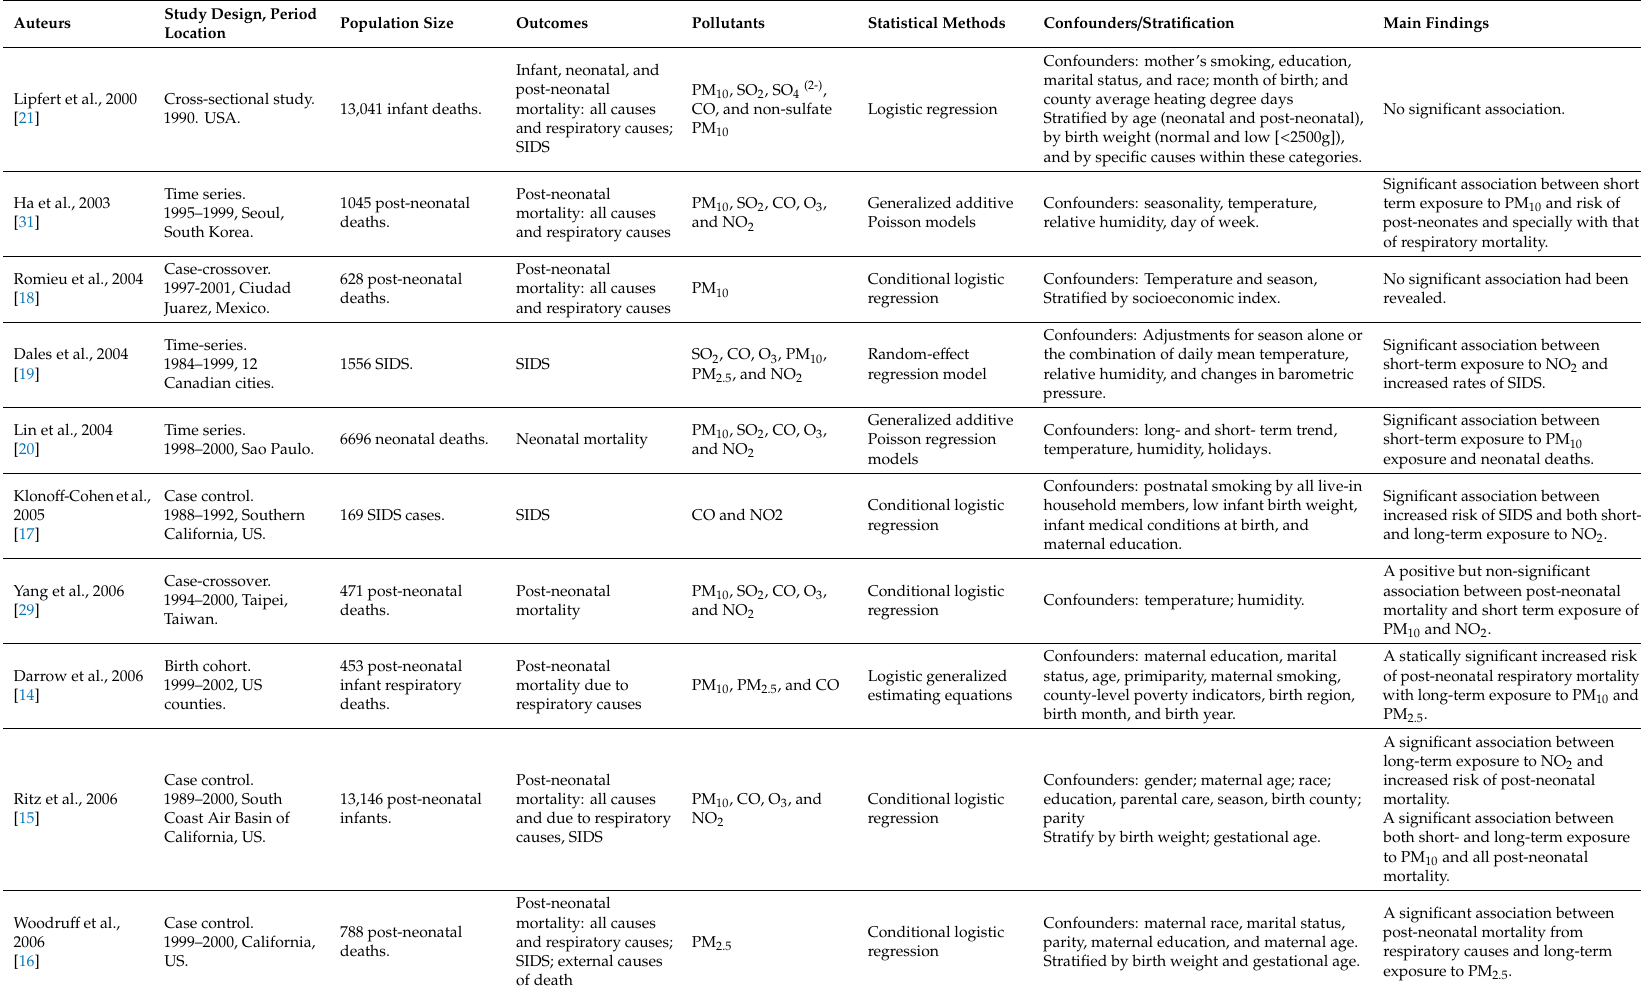
Table 1. Main characteristics of the selected studies, ordered by year of